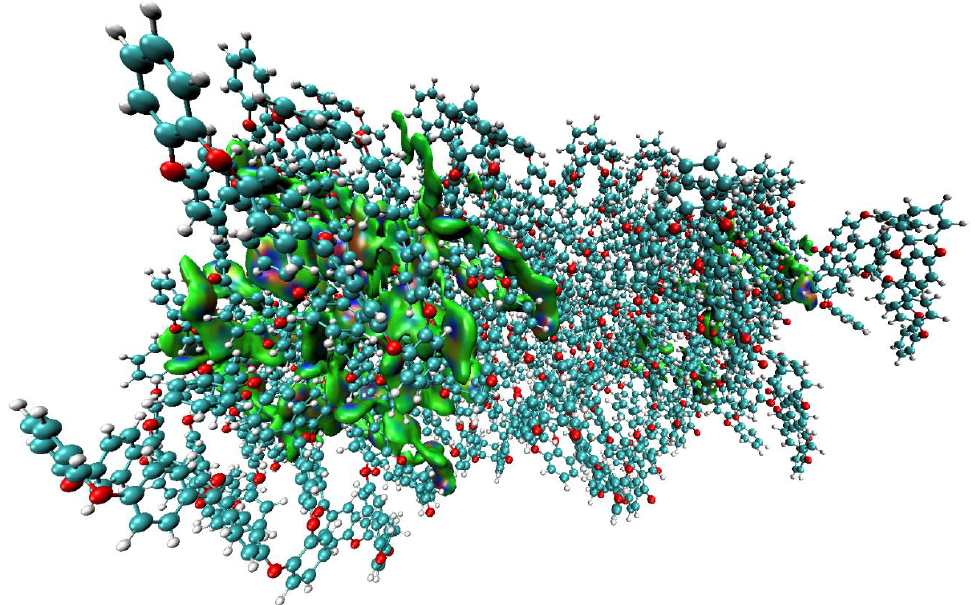
Figure 8. Illustration of dispersed IGM isosurface domains (0.002 a.u.) between 20 randomly selected oligomers of o-PEEK, accountable for the emergence of the semi-crystal. Each oligomer comprises of 136 atoms, and that there are 40 oligomers in the geometry of the 2 × 2 × 2 supercell (5440